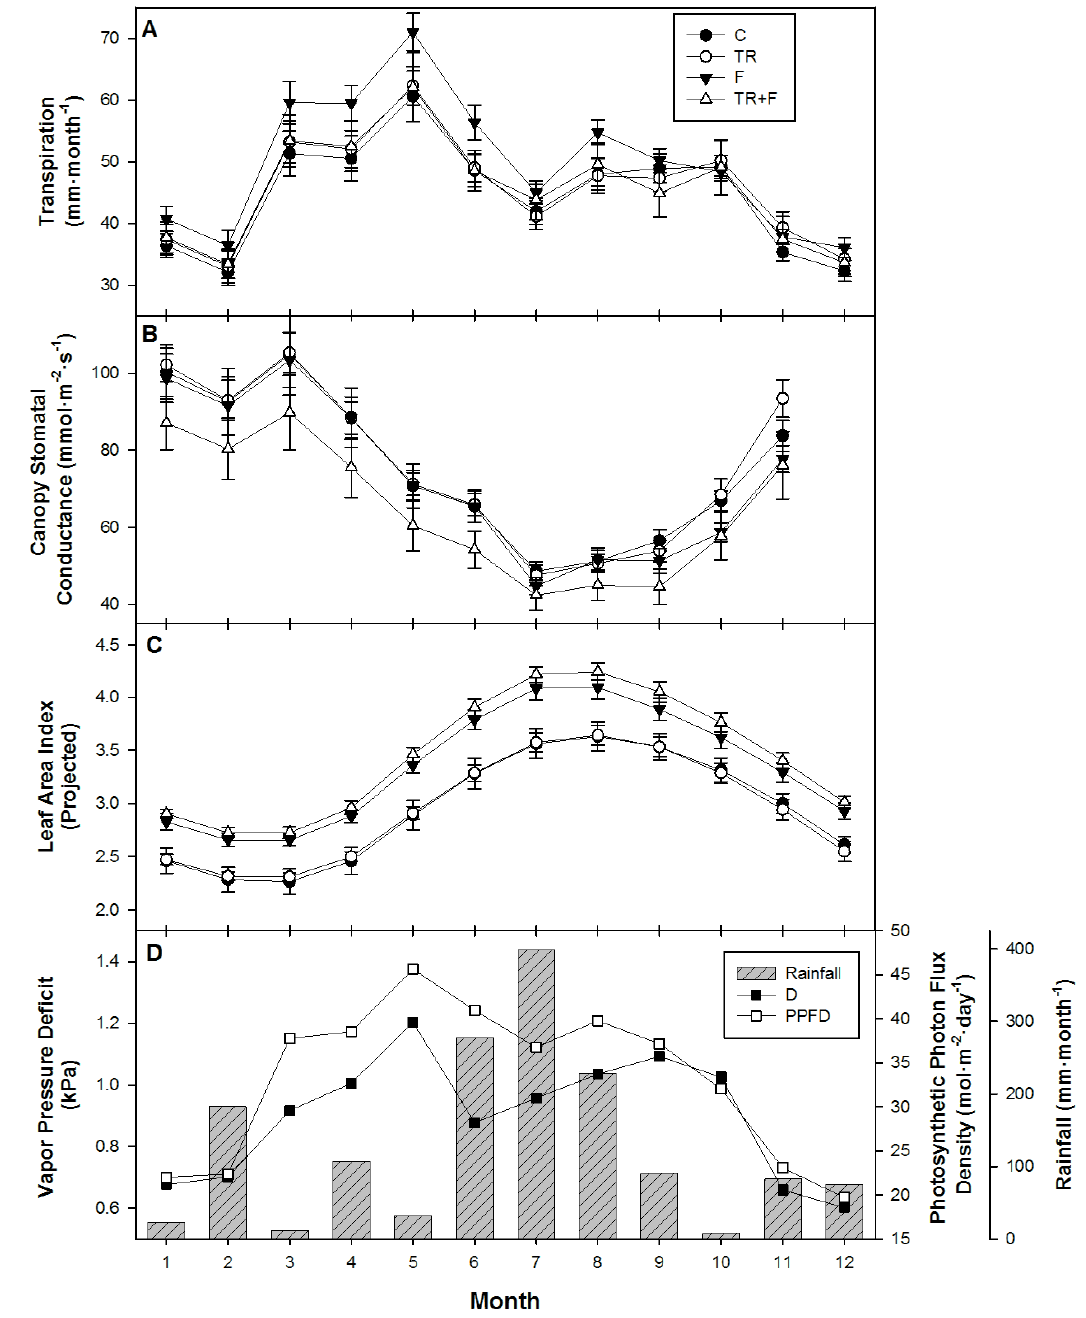
Figure 1. Time series of water relations parameters, leaf area index, and meteorological data during 2013. ( A ) Total monthly transpiration rate by treatment; ( B ) Mean monthly daylight hour stomatal conductance by treatment; ( C ) Mean monthly LAI by treatment; ( D ) Mean daylight hour vapor pressure deficit (D), monthly mean total daily photosynthetic photon flux density (PPFD), and total monthly rainfall for 2013. Treatments include control (C), throughfall reduction (TR), fertilizer application (F), and throughfall reduction and fertilizer application (TR+F). Error bars represent ± 1 standard error.